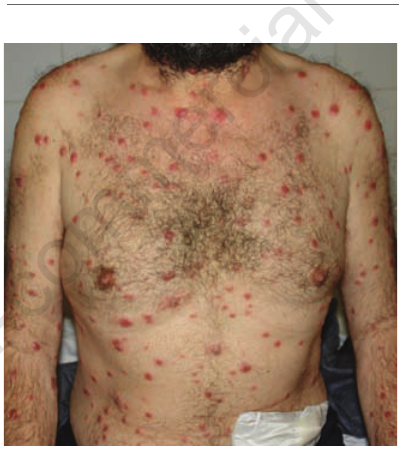
Figure 1. Erythematous ulceronodular lesions on the face producing a leonine facies.